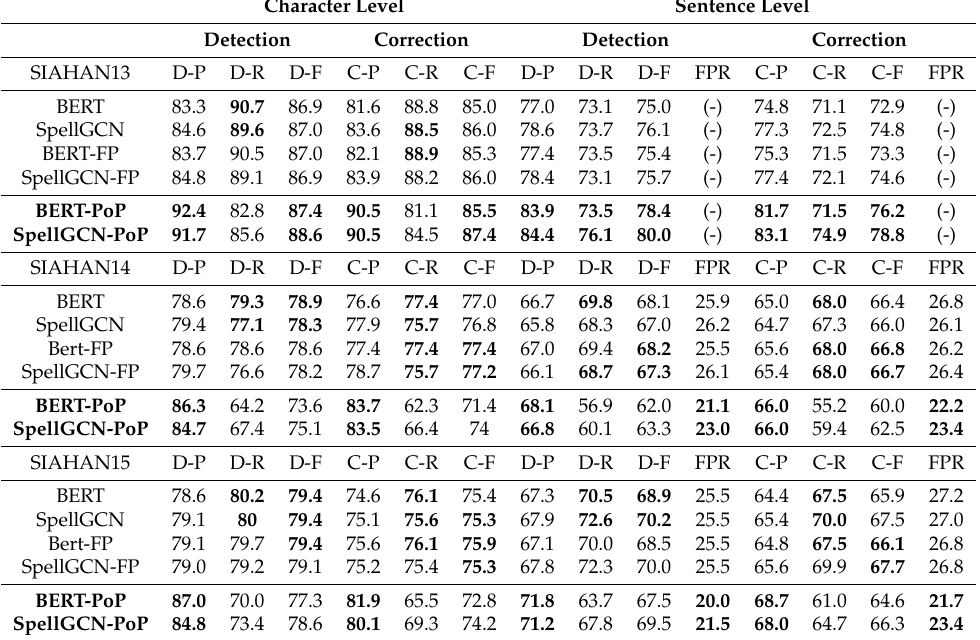
Table 3. The test results after the post-processing operation on the two basic models. We recorded detailed different test indicators of two different subtasks: error detection and error correction on the test set in terms of character level and sentence level. P, R, F represent Precision, Recall, and F1 score. In the sentence level test, we also introduced the False Positive Rate (FPR). We intensified the improved results compared to the original model after introducing post-processing operation as an experimental comparison. FP denotes filter by probability, and PoP denotes